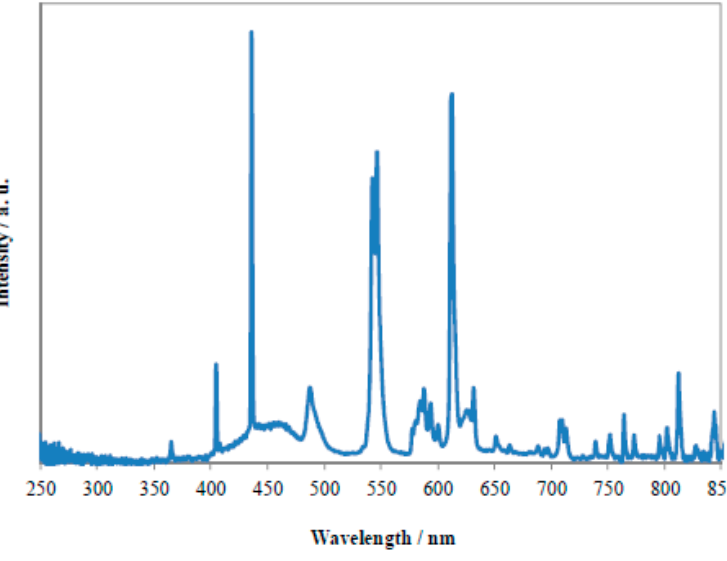
Figure 13. The emission spectrum of a fluorescent lamp.